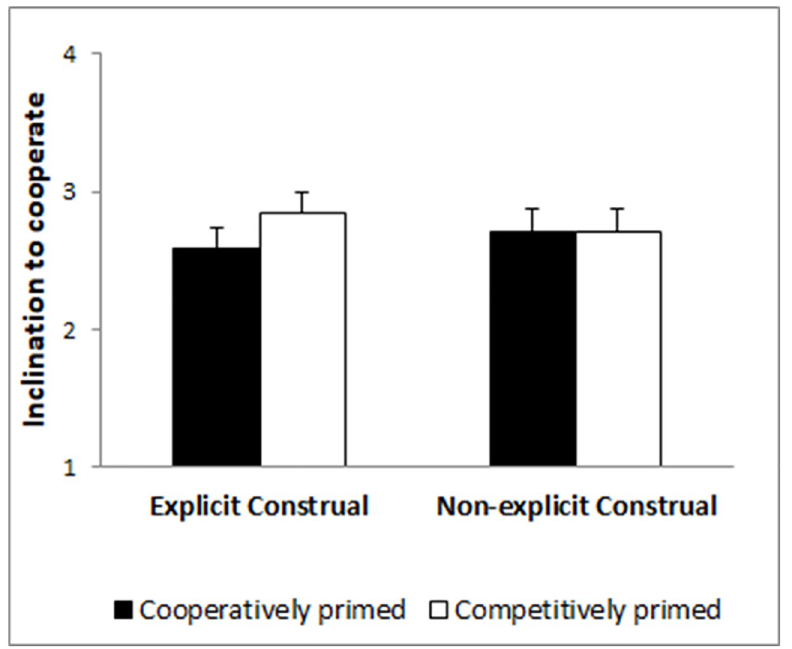
Fig 2. Intention to cooperate as a function of priming and construal order